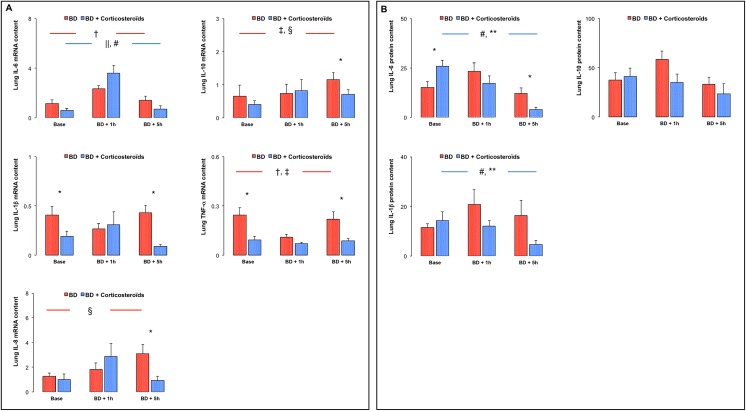
Lung expression of TNF-α and cytokines in brain death (BD)-induced lung injury.Panel A. Relative lung mRNA expression of interleukin (IL)-6, IL-10, IL-1β, TNF-α and IL-8 at baseline, one (BD + 1 hour) and five (BD + 5 hours) hours after Cushing reflex in the placebo-pretreated brain death (BD group; n = 11; red bars) and in the methylprednisolone-pretreated brain death (BD + Corticosteroids; n = 8; blue bars) groups. Panel B: Lung protein content for IL-6, IL-10 and IL-1β at baseline, one (BD + 1 hour) and five (BD + 5 hours) hours after Cushing reflex in the placebo-pretreated brain death (BD group; n = 11; red bars) and in the methylprednisolone-pretreated brain death (BD + Corticosteroids; n = 8; blue bars) groups. Values are expressed as mean ± SEM. * p<0.05 BD versus BD + Corticosteroids; † p<0.05 Base versus BD + 1 hour, ‡ p<0.05 BD + 1 hour versus BD + 5 hours, § p<0.05 Base versus BD + 5 hours in the BD group; || p<0.05 Base versus BD + 1 hour, # p<0.05 BD + 1 hour versus BD + 5 hours, ** p<0.05 Base versus BD + 5 hours in the BD + Corticosteroids group.